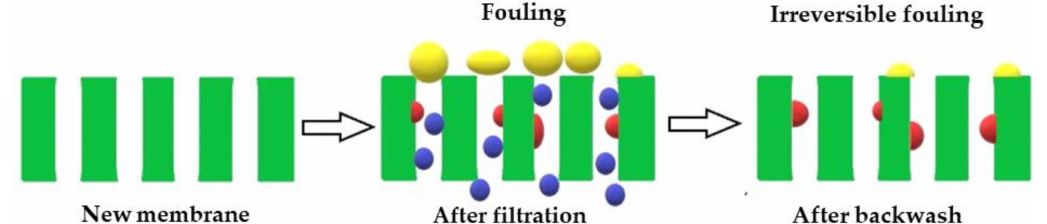
Figure 12. Illustration of membrane fouling and irreversible fouling after filtration and after